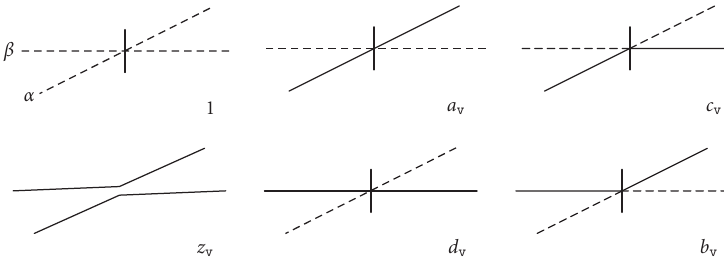
Figure 2.5. Six variants of bypassing the vertex. Vertex factors f v are matrix elements of L . Note that in the variant z v the path is not